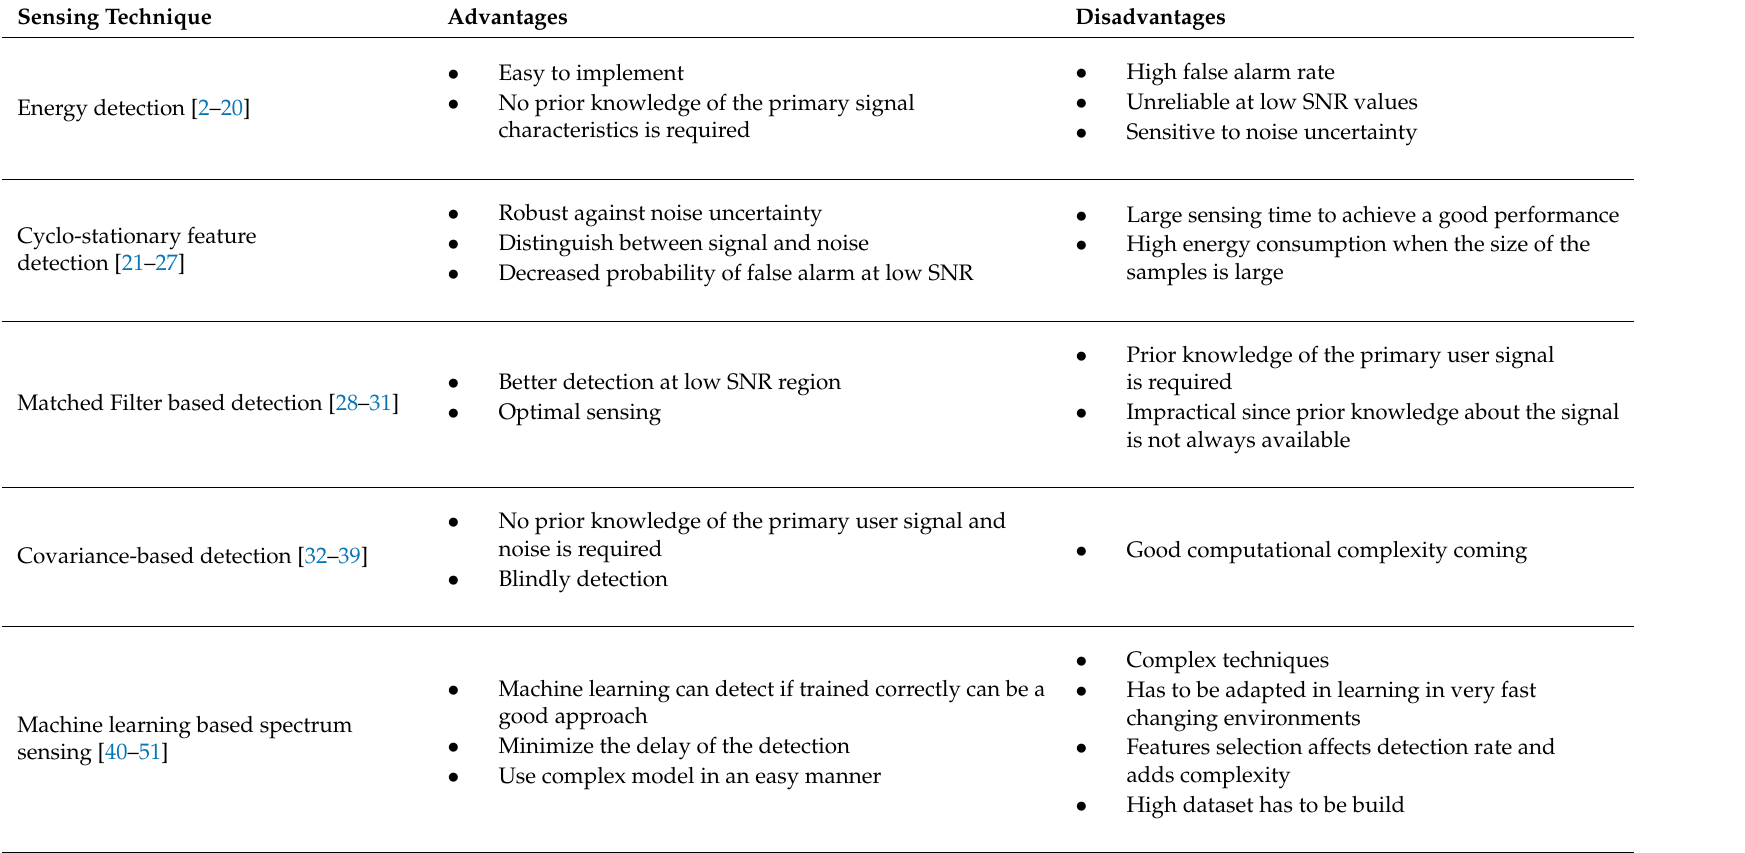
Table 3. Advantages and disadvantages of the four narrowband spectrum sensing